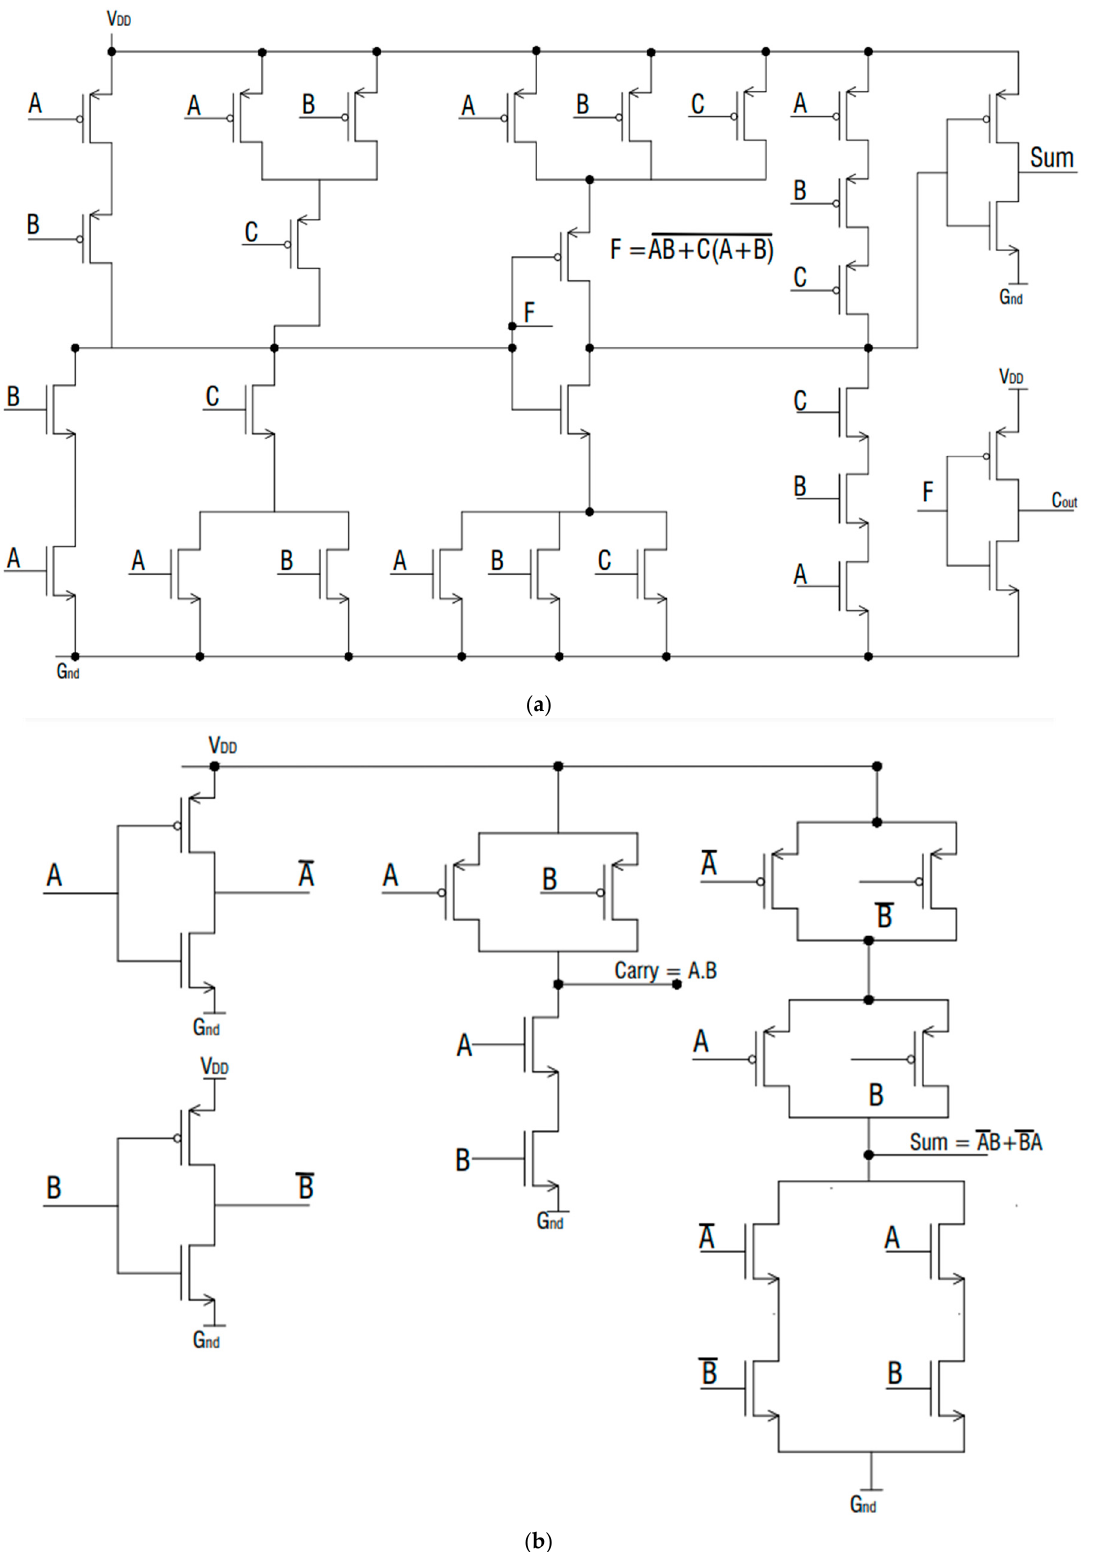
Figure 2. ( a ) Schematic design of static CMOS single-bit full adder; ( b ) Schematic design of static CMOS single-bit half adder.